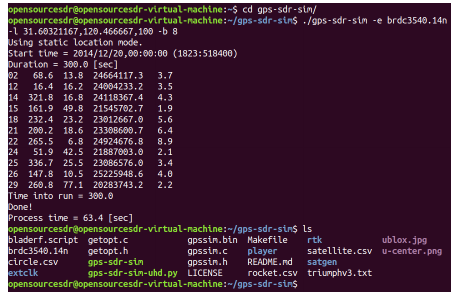
Figure 16. Generation of GPS spoofing data.